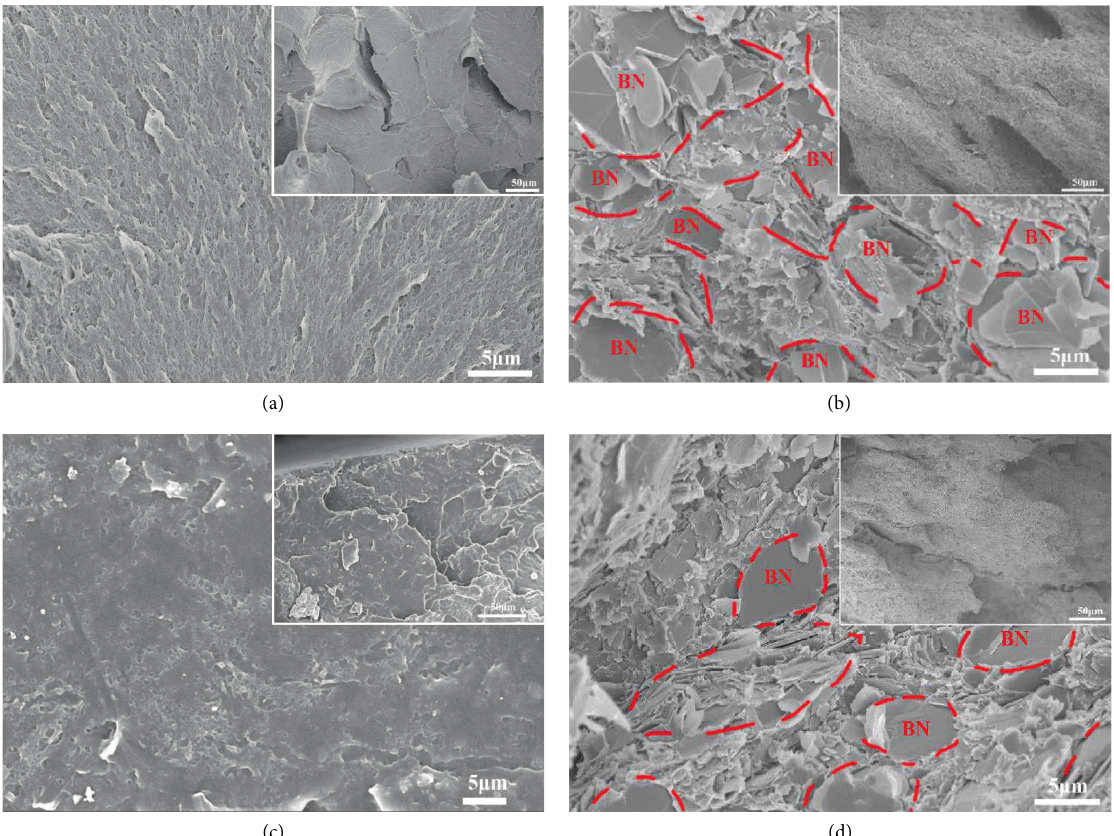
Figure 2: SEM of UHMPWE/BN composites by solvent mixing (a) 0 wt% BN; (b) 40 wt% BN; and melt mixing. (c) 0 wt% BN; (d) 40 wt% BN.